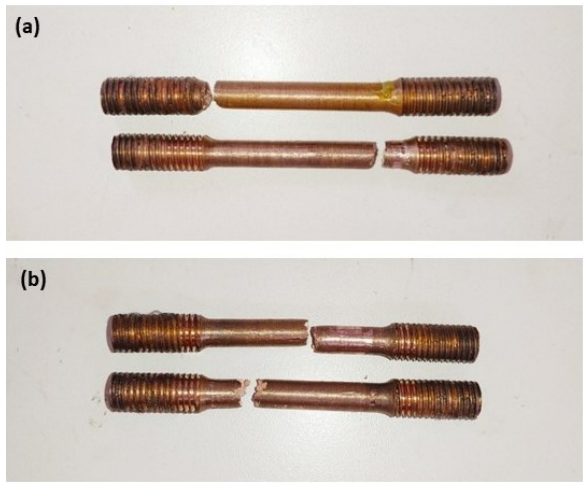
Figure 6: Fractured tensile specimens of (a) base metal ‘A’ and (b) ASiN composite.